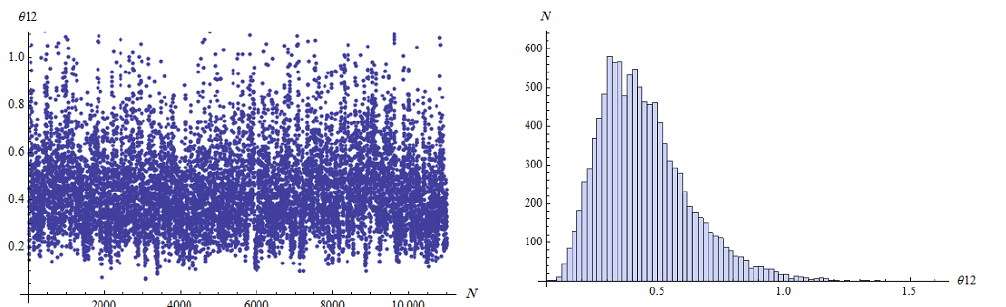
Figure 3. Trace ( Left ) and histogram ( Right ) plots of the parameter θ 12